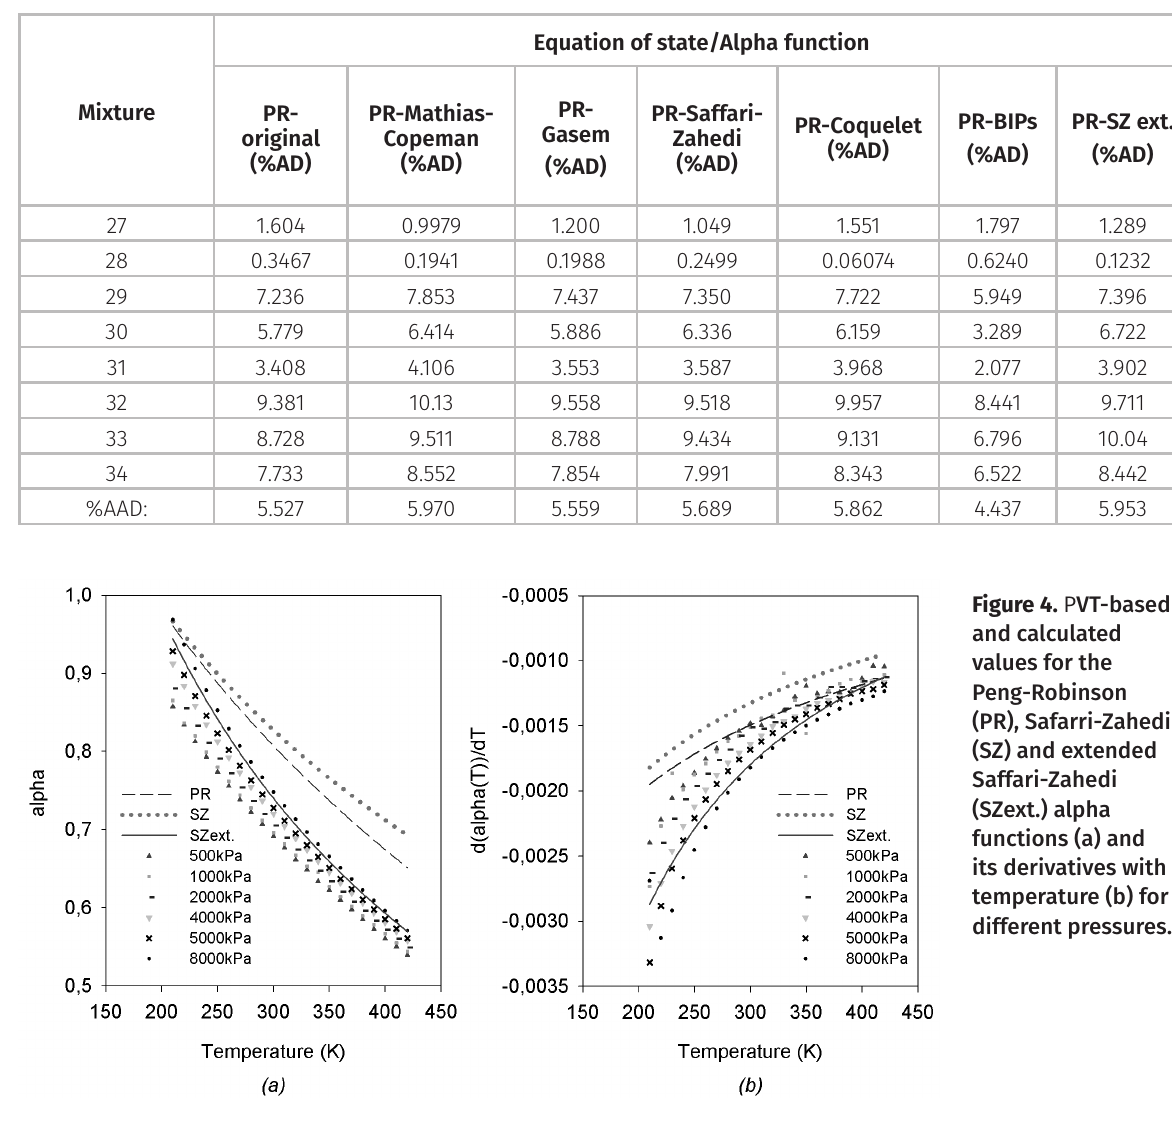
PR-BIPs PR-Coquelet (%AD)